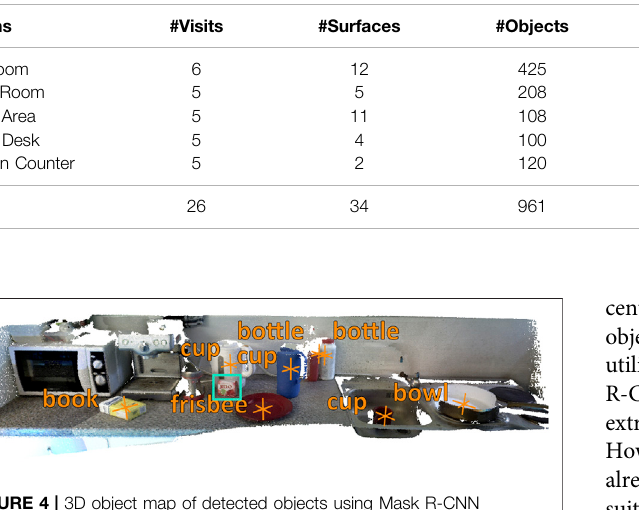
Frontiers in Robotics and AI |